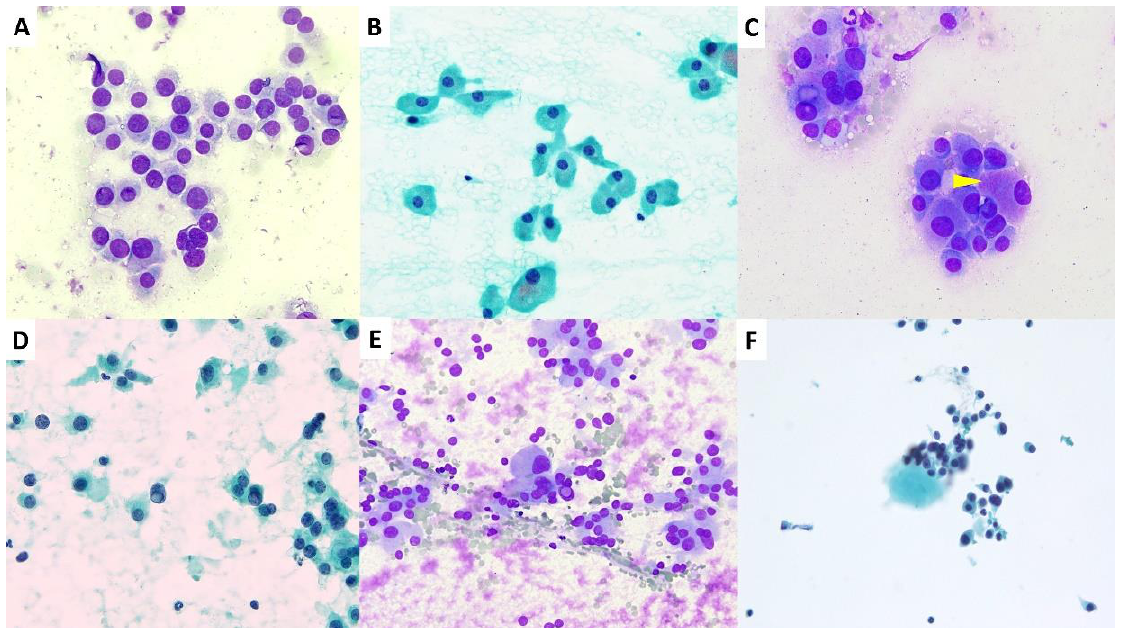
Figure 1. Cytomorphologic features of MTCs in the discordant group. ( A ) Round cells formed loosely cohesive clusters, making a diagnosis of FLUS or SFN (Romanowsky, ×400). ( B , C ) Polygonal tumor cells with abundant cytoplasm or cytoplasmic granules (( C ); arrowhead), making a diagnosis of Hurthle cell neoplasm or FLUS (( B ) Papanicolaou, ×400; ( C ) Liu, ×400). ( D , E ) Intranuclear cytoplasmic pseudoinclusion (center) mimicking papillary thyroid carcinoma (( D ) Papanicolaou, ×400; ( E ): Liu, ×400). ( F ) A few plasmacytoid cells with preserved background colloid prompted an indeterminate diagnosis of AUS/FLUS (Papanicolaou, ×200).